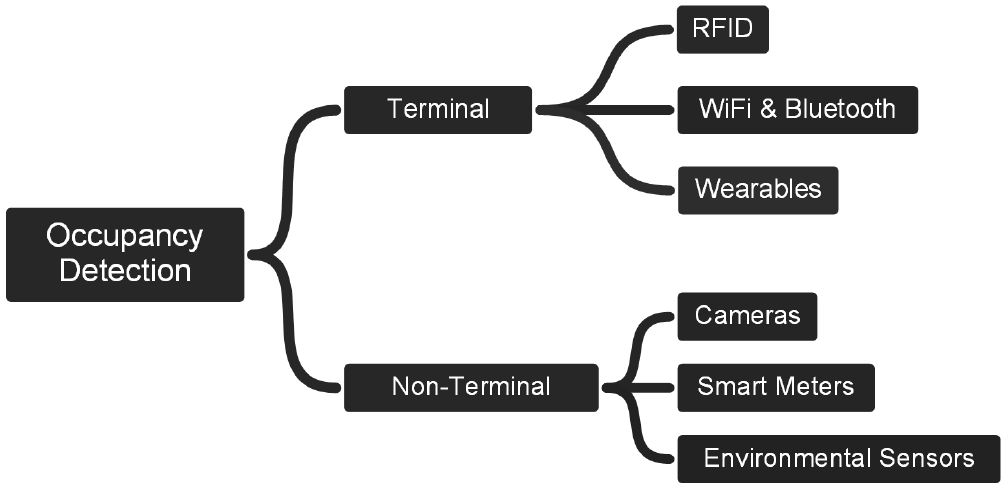
Figure 1. A simple classification of occupancy/location detection